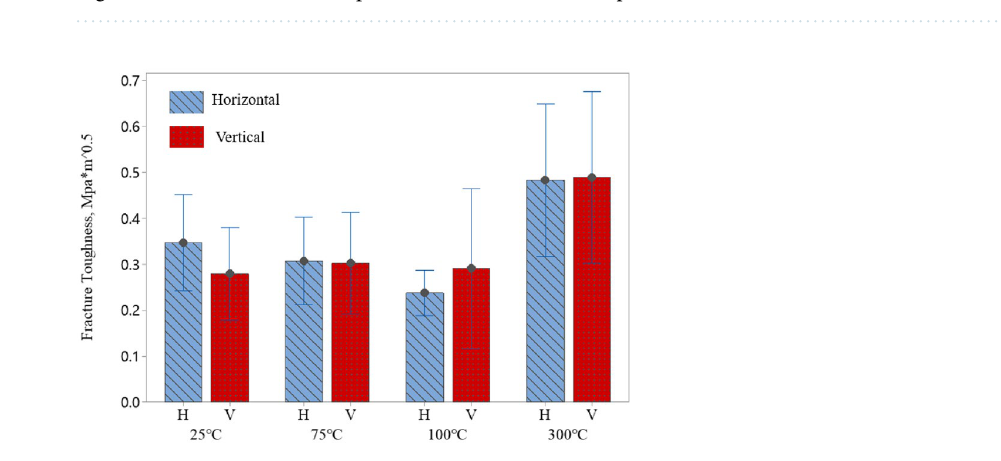
Figure 5. Fracture toughness values of shale samples in both vertical and horizontal bedding